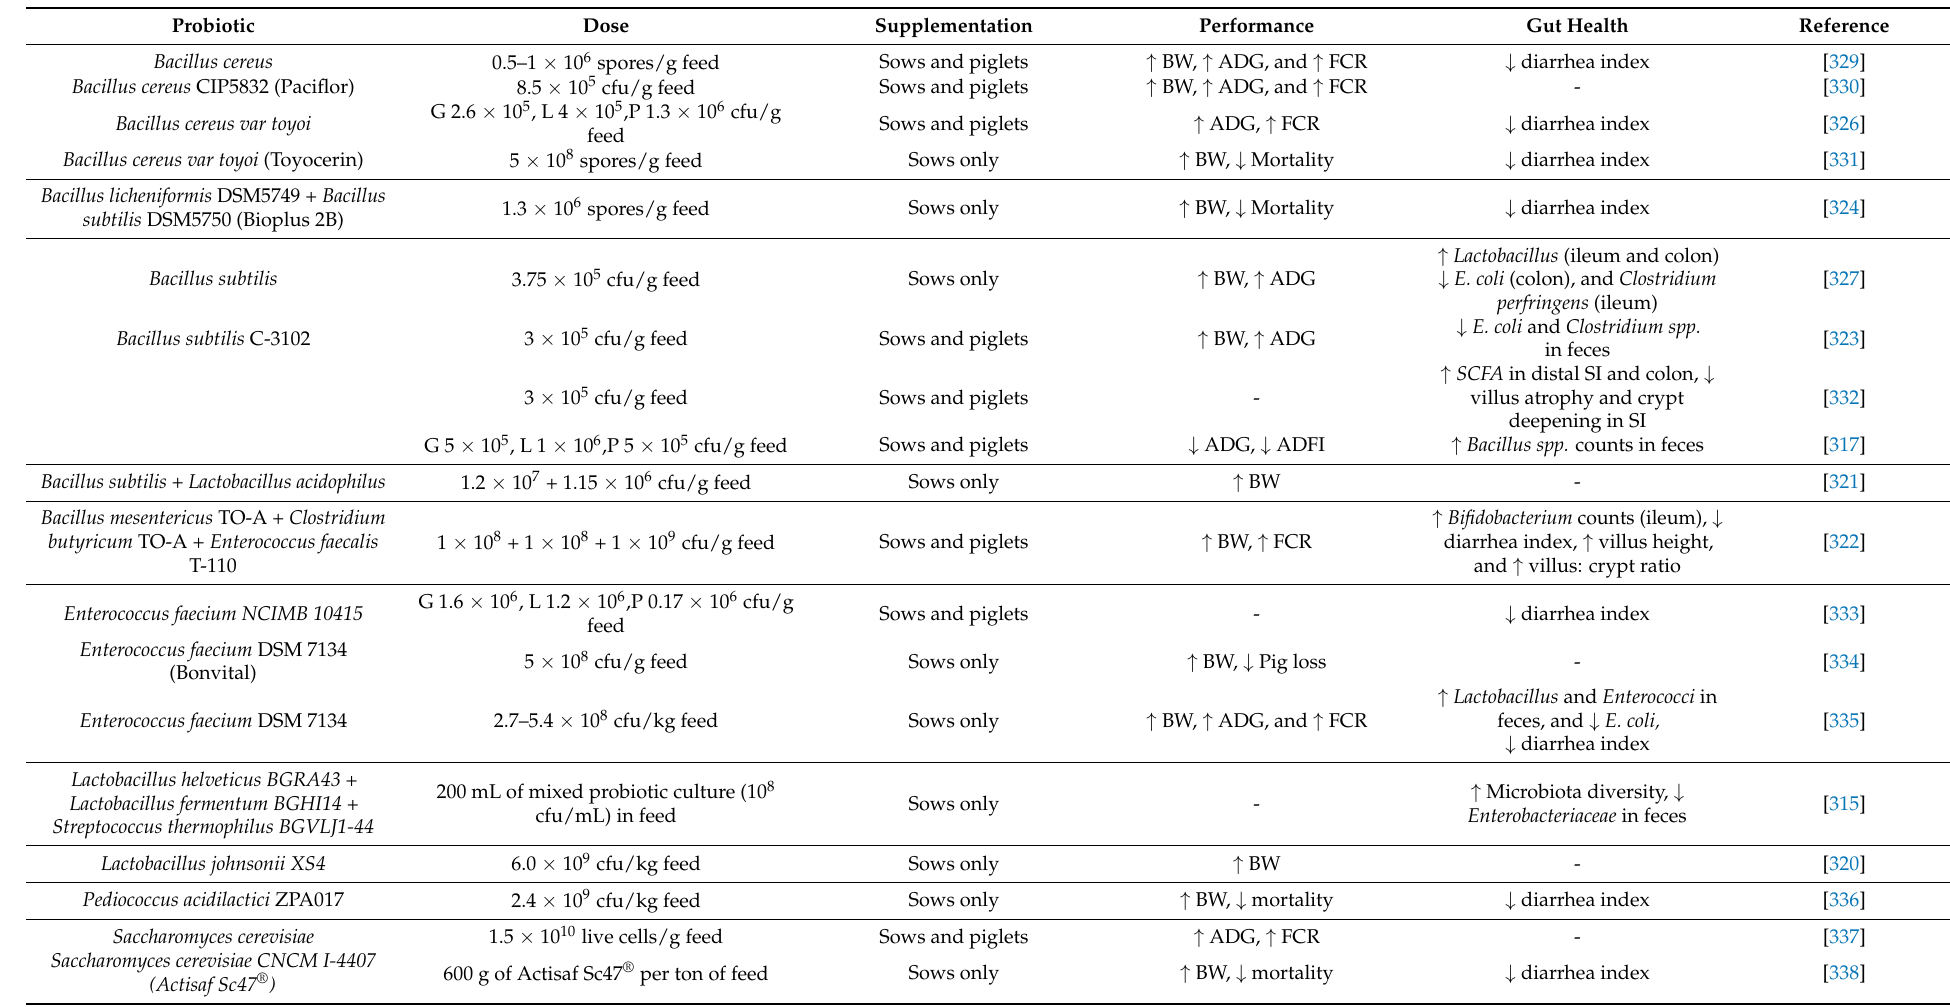
Table 7. Effects of probiotic supplementation of sows on piglet performance and gut